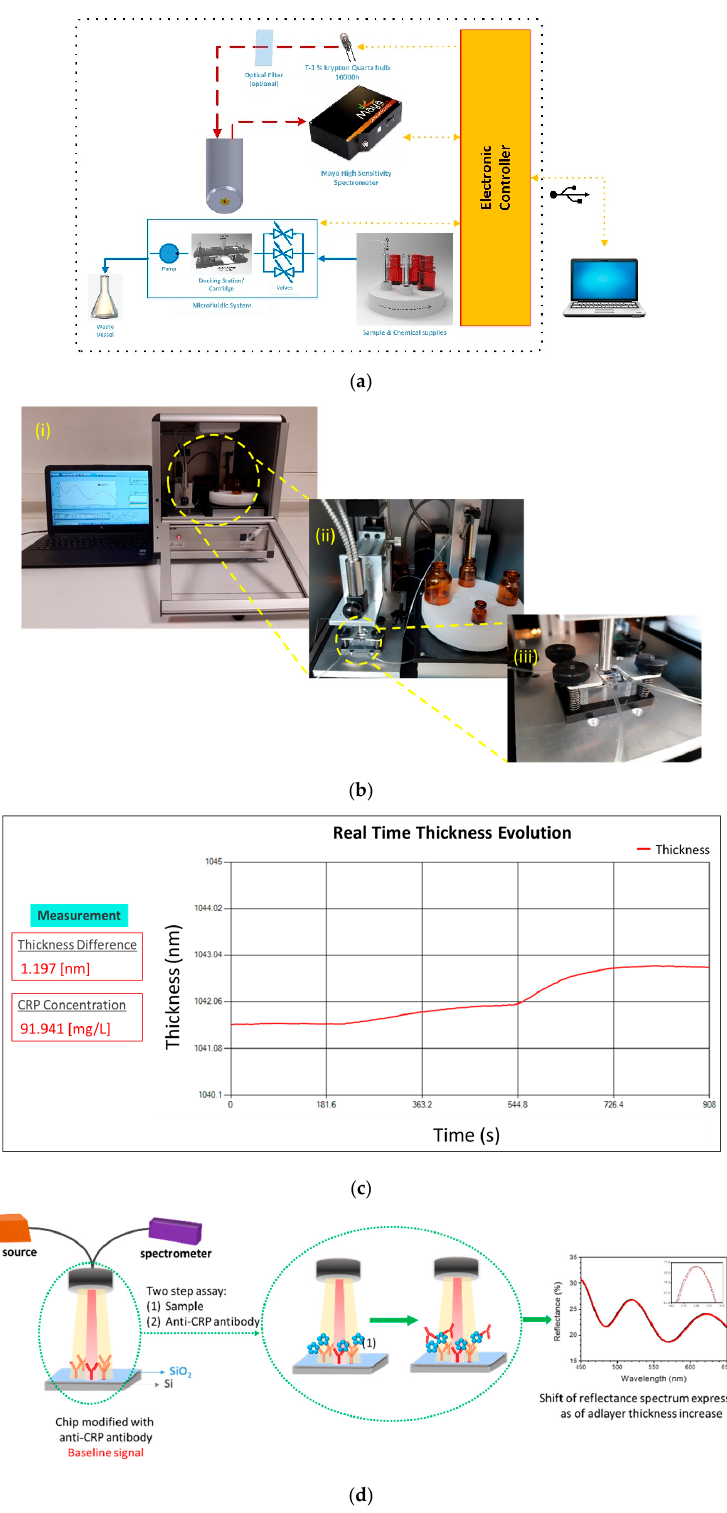
Figure 1. ( a ) Depiction of the main part of the instrument. ( b ) Images of the: (i) whole instrument and accompanying PC, (ii) fluidic module, and (iii) docking station. ( c ) Depiction of the PC screen at the end of a run. ( d ) Schematic of the chip, sensing principle and two-site sandwich immunoassay